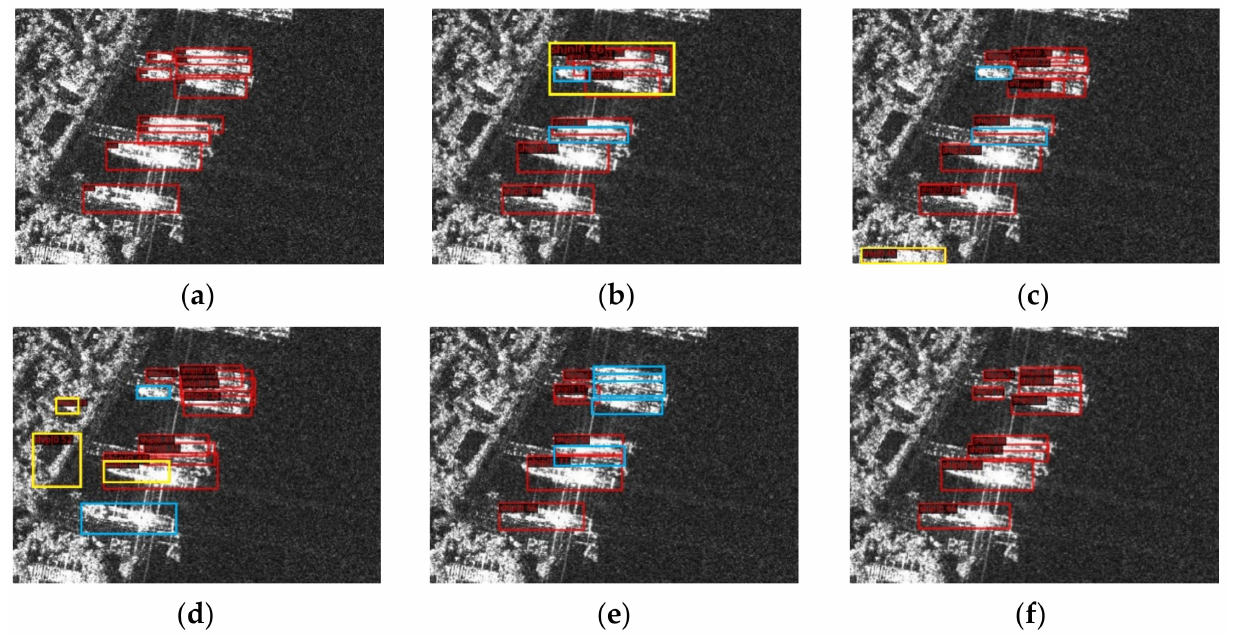
Figure 11. Visualization detection results of in-shore scenes in the SSDD dataset: ( a ) ground truth; ( b ) Faster RCNN; ( c ) Cascade RCNN; ( d ) Retinanet; ( e ) FCOS; and ( f ) proposed method. (The red boxes represent ground truths and true positives; the yellow boxes represent false alarms; the blue boxes represent missed